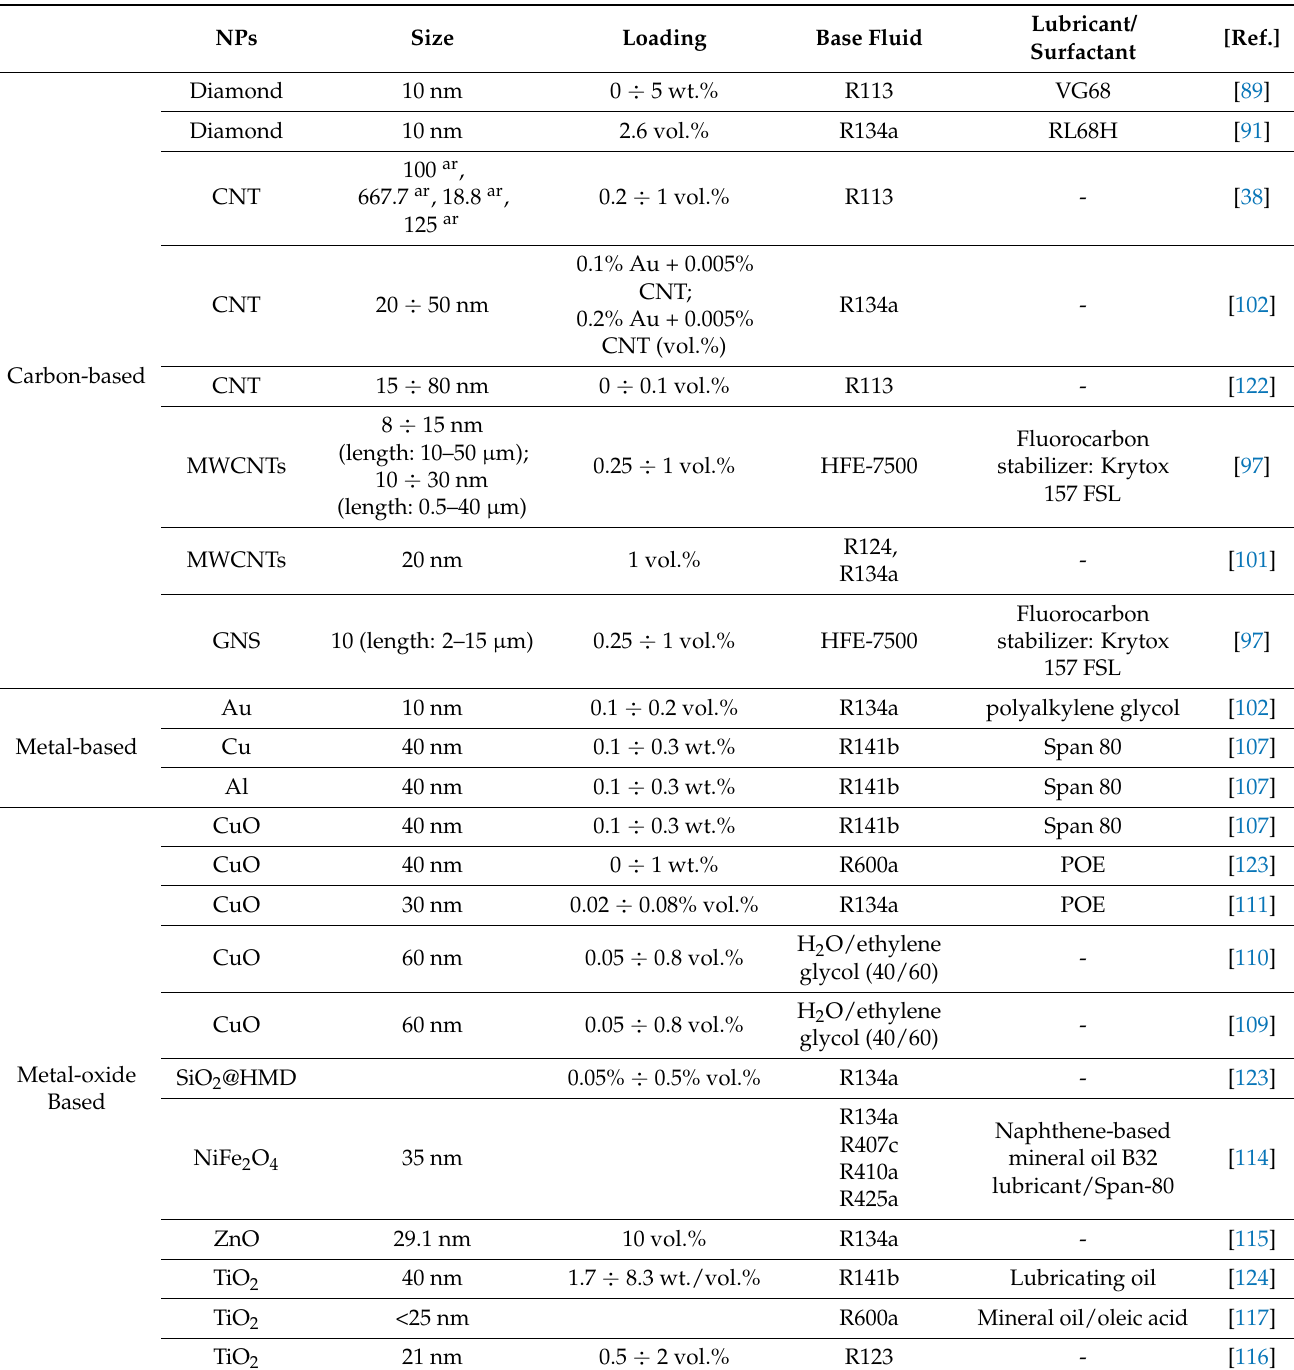
Table 2. Overview of various studies of